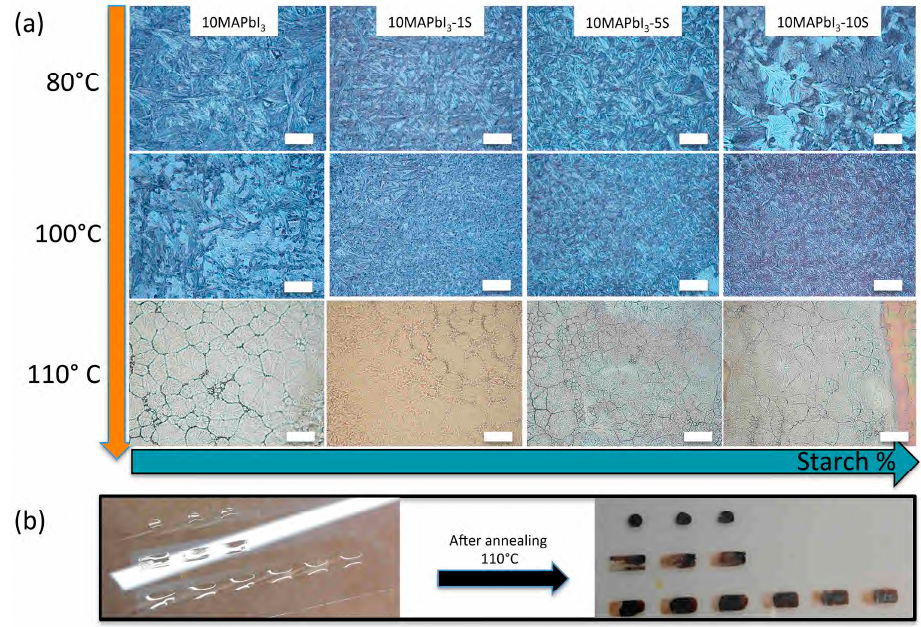
Figure 4. Optical microscope images of different precursor perovskite solution printed patterns annealed at different temperatures (scale bar 100 µ m) ( a ), and “shift” of the drops observed after thermal annealing at 110 °C for different starch concentrations ( b ).